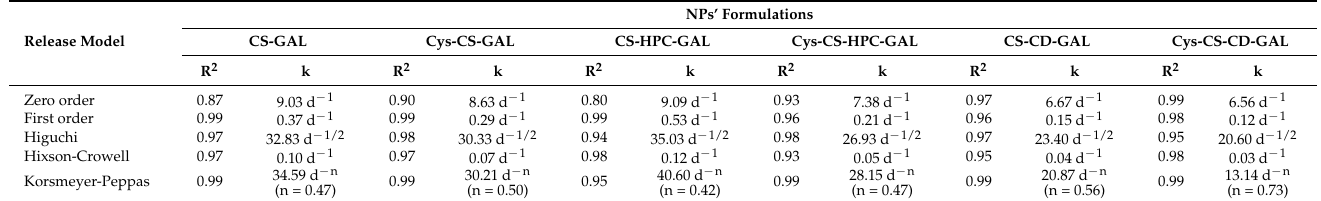
Table 3. Dissolution data model fitting results for the employed drug release kinetic